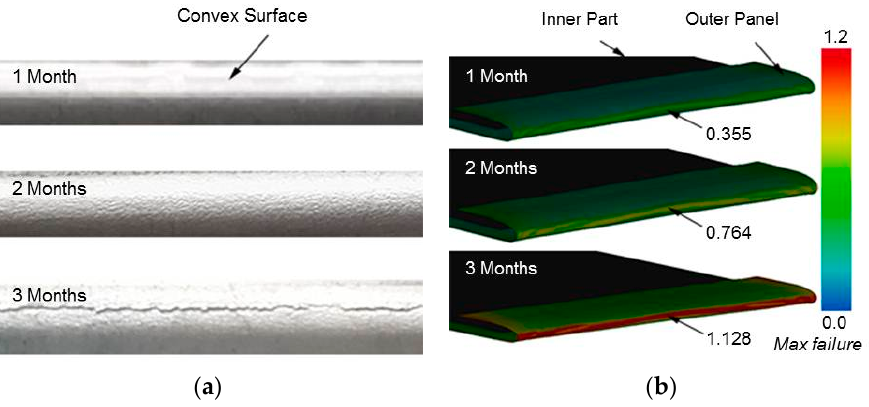
Figure 13. Experimental and numerical results for fracture in die hemming process with a R f of 1.2 mm: ( a ) convex surface images of the outer panels and ( b ) Max failure indicator in simulation.